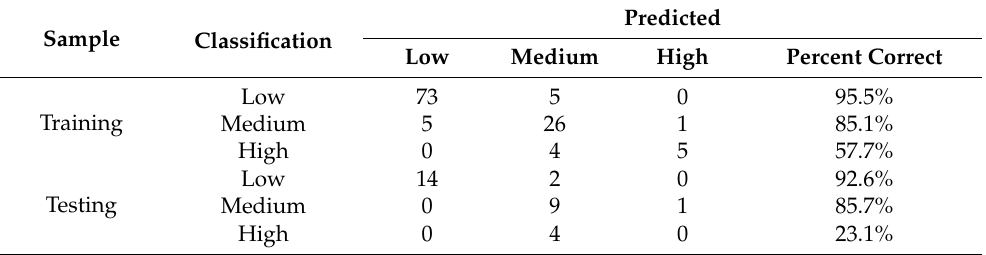
Table 9. Classification of overall